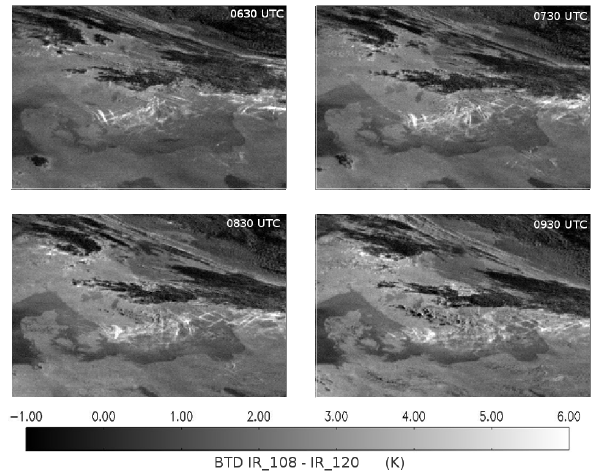
Fig. 1. Four examples of BTD images showing the evolution of Fig. 01. Four examples of BTD images showing the evolution of contrails over southern Sweden over three hours. 06:30UTC: con- trails appear as linear structures with a high BTD signal (light grey contrails over southern Sweden over three hours. 06:30 UTC: con- – white). It can be seen that the older contrails are, the more diffi- trails appear as linear structures with a high BTD signal (light grey cult is to identify them as such without temporal information. Date: – white). It can be seen that the older contrails are, the more diffi- 3 July cult is to identify them as such without temporal information. Date: 3 July 2009.